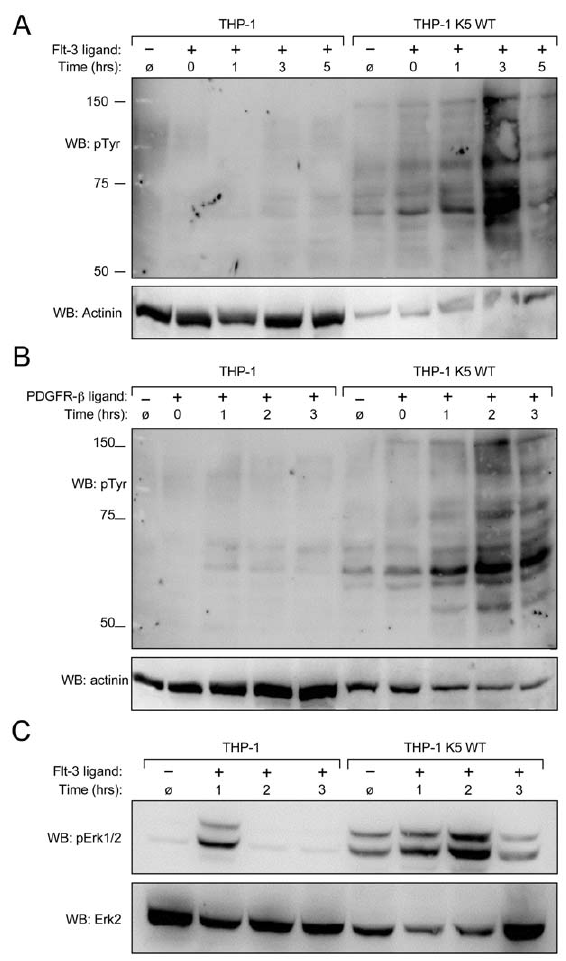
Figure 6. K5 WT-THP-1 cells are more responsive to Flt-3 and PDGF-ß-induced signaling and have increased Erk activation. Equal numbers of vector- and K5 WT-expressing THP-1 cells were serum starved overnight and stimulated with ( A and C ) Flt-3L (40 ng/ml) or ( B ) PDGF-ß (20 ng/ml) for ten minutes after which cells were washed and then treated with pervanadate for ten minutes at the times indicated. Western blot (WB) was performed on normalized whole cell lysates using ( A and B ) anti-phospho-tyrosine (4G10) (pTyr) or ( C ) anti- phospho-Erk antibodies. For panels A and B , 10 ug of THP-1 K5 WT lysate and 30 ug of THP-1 lysate were loaded to make comparison of bands easier between the two cell lines. Equal amounts of each lysate, 30 ug/lane, were loaded for panel C . Blots were re-probed for actinin ( A and B ) or total Erk ( C ). Data are representative of three independent